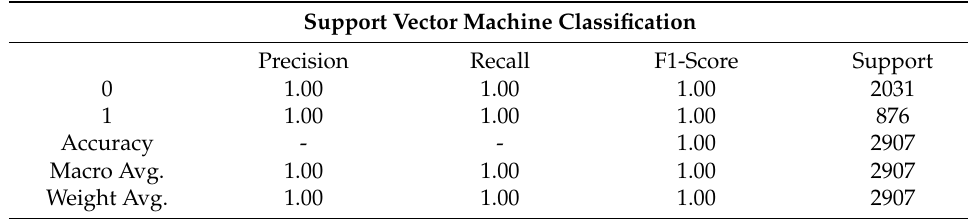
Table 5. Support vector machine classification report.